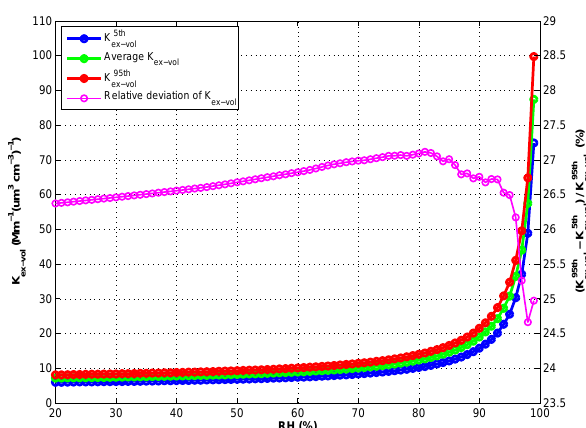
Fig. 5. Variation of the aerosol volume extinction coefficients ( K ex-vol ) with RH. Green, blue and red circled lines stand for the average, the 5th and the 95th percentiles of the volume extinc- tion coefficients ( K 5 th and K 95 th ). The magenta line represents ex-vol ex-vol − the relative deviations of K ex-vol , which is defined as ( K 95 th ex-vol K 5 th )/ K 95 th . ex-vol ex-vol